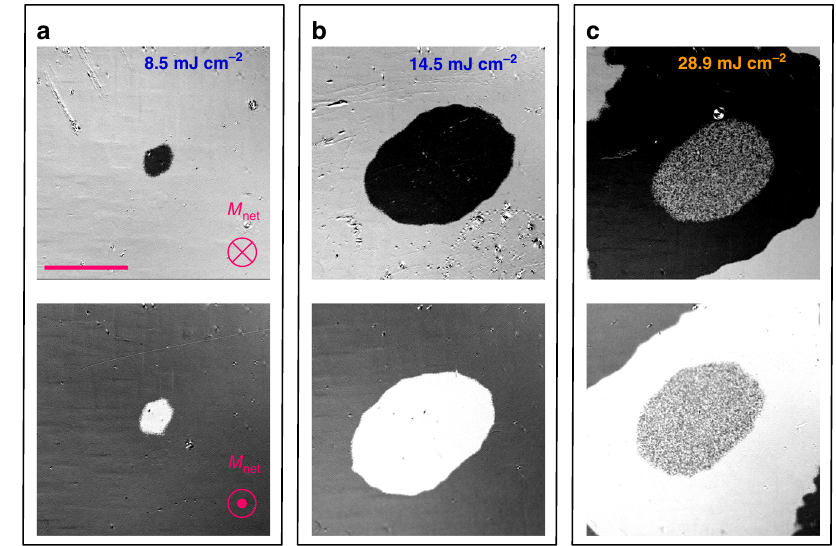
Fig. 1 Single-pulse all-optical switching (SP-AOS) in Mn 2 Ru 1.0 Ga. A uniformly-magnetized fi lm with net magnetization M net out of the plane (top) or into the plane (bottom) is irradiated by a single 800 nm pulse focused onto a ~100 µ m spot. The pulse energy in a is 8.6 mJ cm − 2 , which only exceeds the switching threshold in a small region at the center, where the fl uence is highest. The 14.5 mJ cm − 2 pulse in b switches the whole irradiated area, whereas the 28.9 mJ cm − 2 pulse in c heats the fi lm at the center of the spot above the Curie temperature, producing a fi ne multidomain pattern. The most intense pulses (43.4 mJ cm − 2 ) lead to ablation of the fi lm. The scale bar represents a length of 50 µ m.